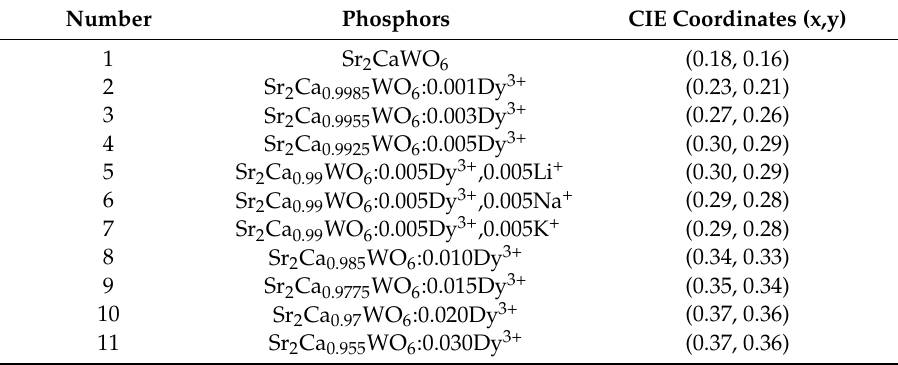
Table 1. Commission International de I’Eclairage (CIE) coordinates of different Dy 3+ ion concentration of Sr 2 CaWO 6